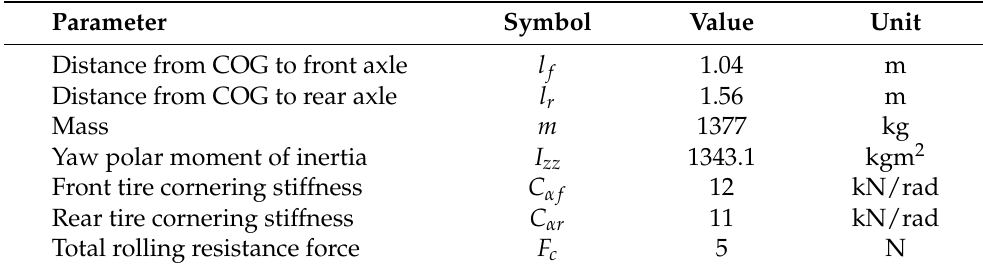
Table 2. B-class hatchback electric vehicle model parameters. Parameter